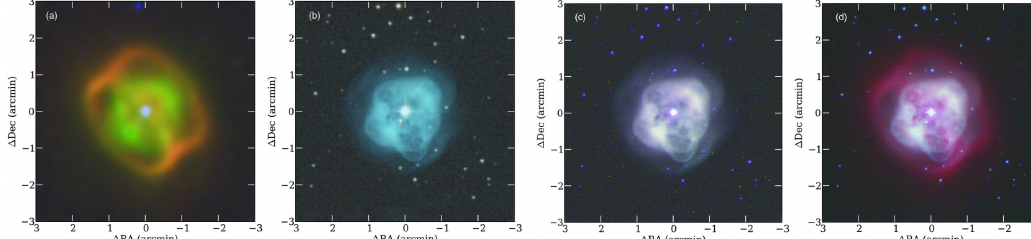
Figure 6. (adapted from [52]) The PN, NGC 1514 as seen with WISE and visible wavelength filters. ( a ) WISE 3-color image, blue = W2 (4.6 µ m), green = W3 (12 µ m) and red = W4 (deconvolved) (22 µ m). ( b ) Visible 3-color image derived from POSS B, R, and I images (blue = B, green = B+R, red = R+I. ( c ) Visible wavelength combination of blue = POSS B, green = [OIII], and red = H α . ( d ) Combination of blue = POSS B, green = H α , and red =